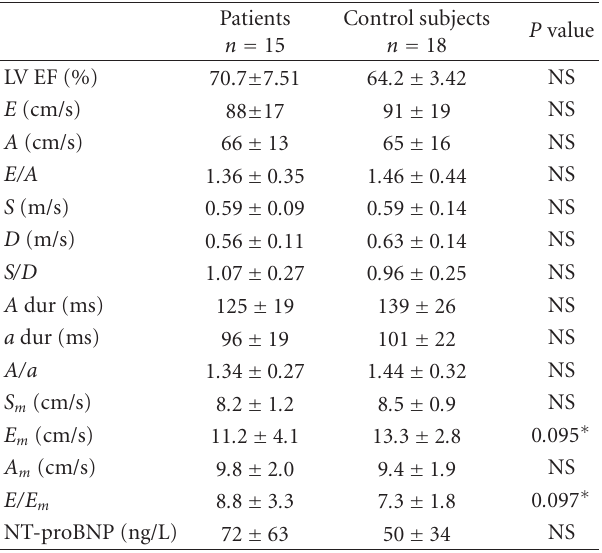
Table 1: Echocardiographic parameters in patients and